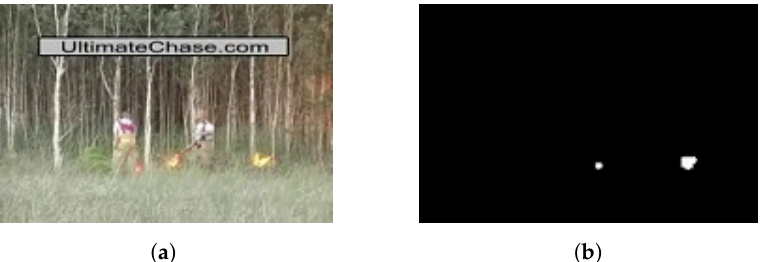
Figure 7. The smallest fire blob that can be detected by our model with area of 20 pixels. ( a ) Original image; ( b ) detected small fire blob.